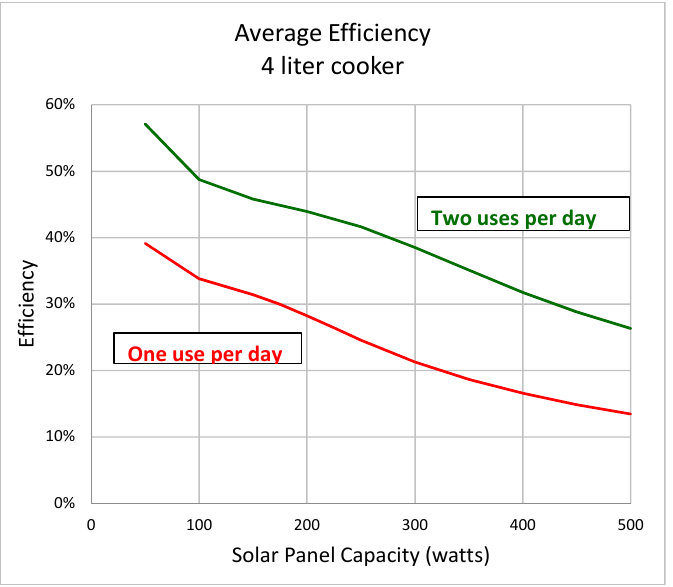
Figure 4. Average efficiency vs. solar panel capacity for a DDS cooker and water heater for two different use cases. In the more efficient use case, water is drawn from the cooker twice per day at noon and 5 p.m. In the less efficient use case, water is drawn once per day at 4 p.m.